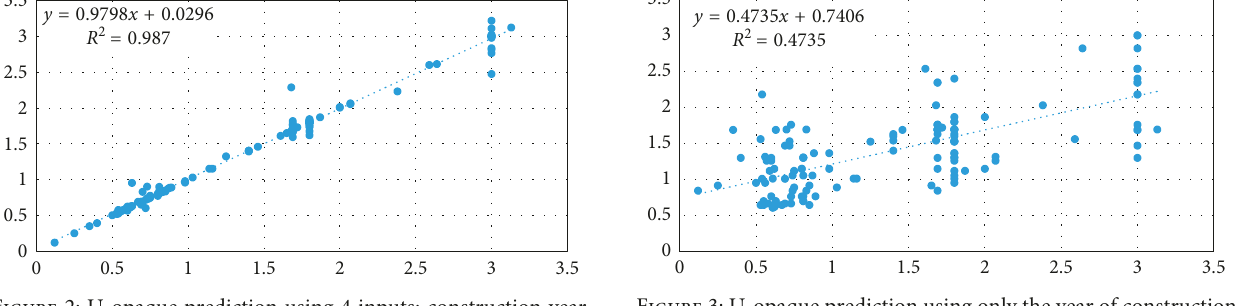
Figure 2: U-opaque prediction using 4 inputs: construction year, useful area, latitude, and longitude.